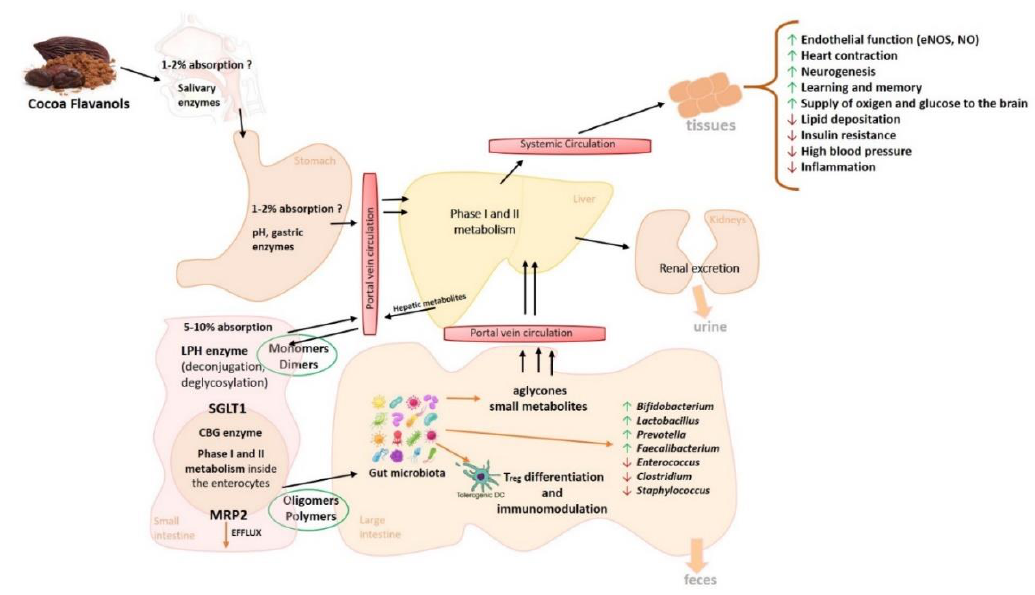
Figure 2. Bioavailability and properties of cocoa polyphenols.